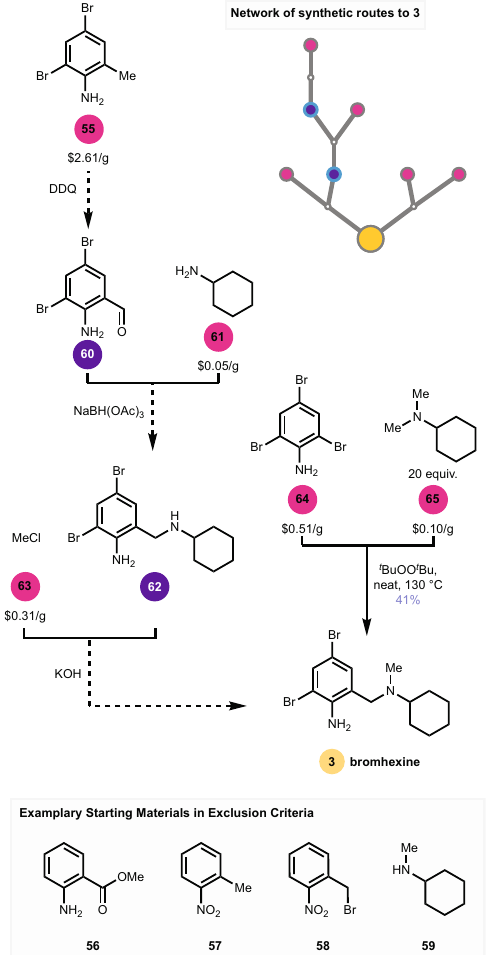
Fig. 5 Predicted and realized routes to 3. Dashed arrows are predicted, while the solid arrow is manually designed and experimentally validated, with the subsequent addition of the key reaction to the SYNTHIA ™